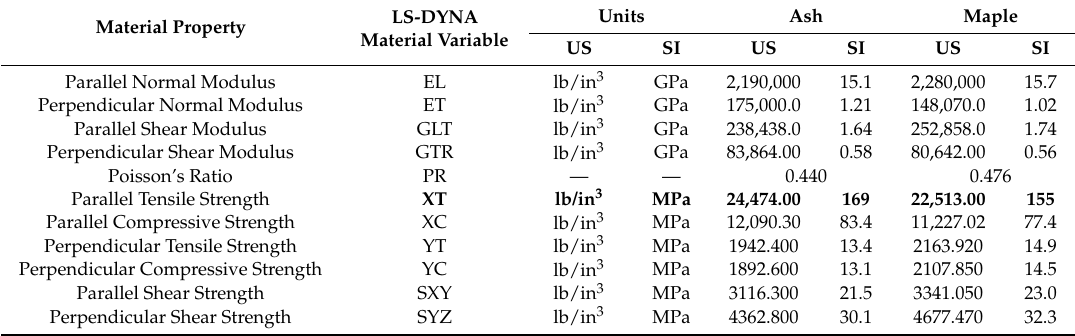
Table 3. MAT_WOOD (MAT_143) maple and ash card 2 and 3 inputs.